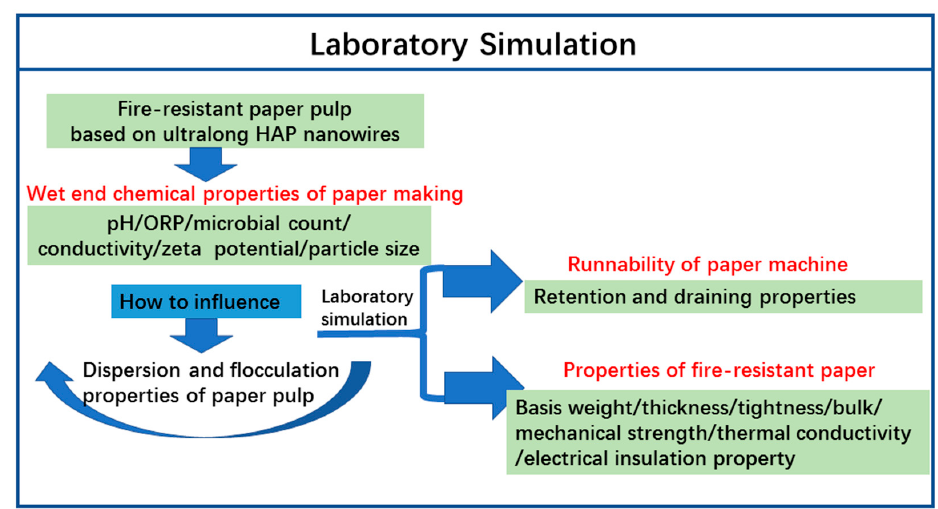
Figure 2. The schematic illustration for the laboratory simulation studies on wet end chemical properties of the fire-resistant paper pulp based on ultralong HAP nanowires. properties of the fire-resistant paper pulp based on ultralong HAP